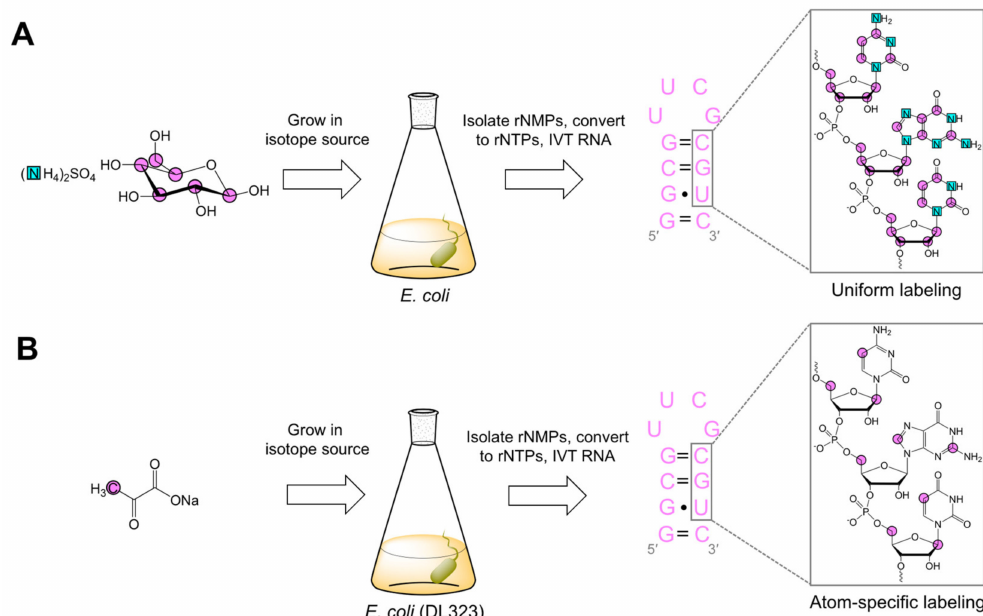
Figure 2. Schematic representations of biomass labeling adapted from the Pardi [22] and Williamson [23] research groups, and our previous work [44]. ( A ) E. coli grown in 13 C-glucose and 15 N-ammonium sulfate yields uniformly 13 C/ 15 N-labeled rNMPs, which can be phosphorylated, forming rNTPs, and then used in IVT to make uniformly (or nucleotide-specifically) labeled RNA. ( B ) E. coli (DL323) grown in [3- 13 C]-pyruvate affords rNTPs, which can then make atom-specifically-labeled RNA. Magenta circles and cyan squares represent 13 C and 15 N, respectively. Additional details can be found in the original works